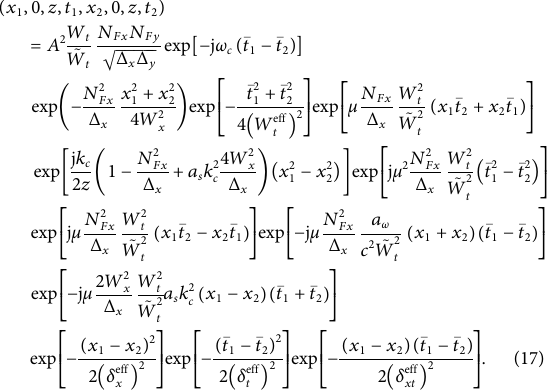
exponentials comprise the ensemble-averaged irradiance (discussed in more detail below). The next (complex) exponentials on line 4 are the spatial and temporal chirps. These are followed by the space-time twist on lines 5 and 6. Lastly, the exponentials on line 7 model spatial and temporal coherence.